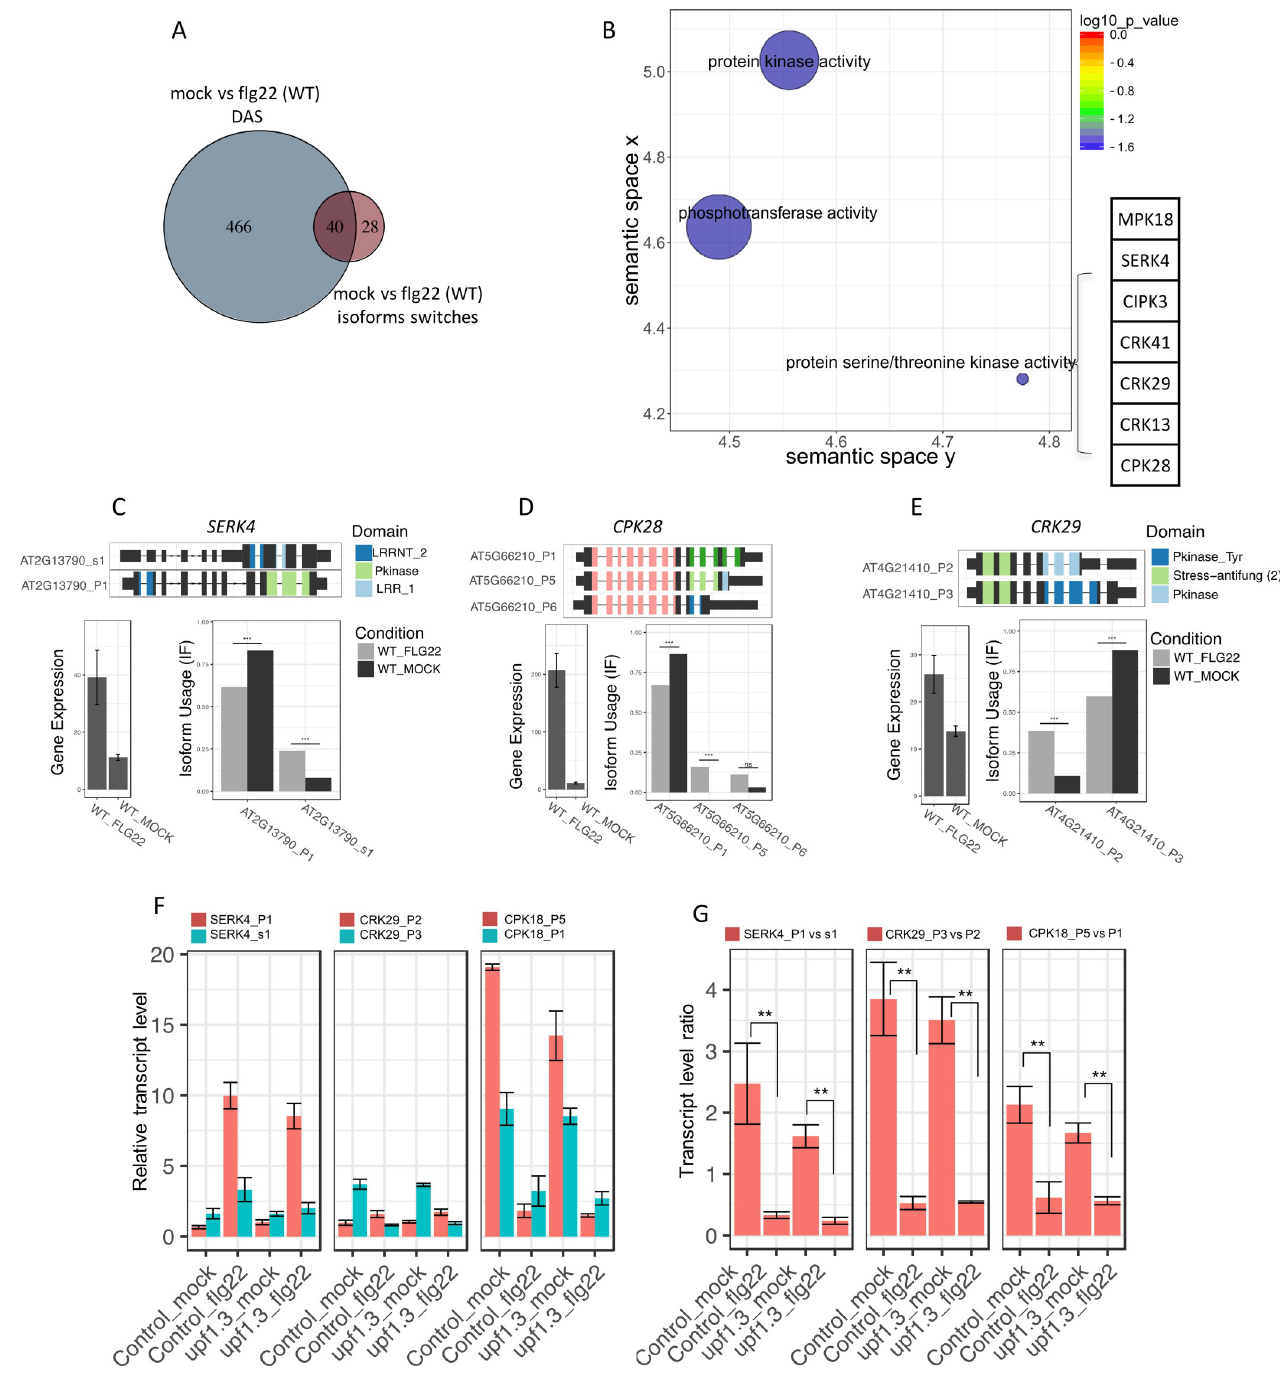
Fig 6. Flg22-induces protein kinase isoform switching. A , Venn comparison plot between DAS genes compared to genes with isoform switching events in response to flg22 in WT. B, REVIGO plots of gene ontology enrichment clusters of DAS genes both in mpk4 compared to wild type and in response to flg22 in wild-type plants. Each circle represents a significant GO category but only groups of highest significance are labeled. Related GOs have similar (x, y) coordinates. C-D-E , Results of IsoformSwitchAnalysisR showing the gene diagram of differential isoforms with the predicted PFAM domain, change in gene expression and relative isoform abundance in response to flg22 and isoform-specific RT-qPCR analysis showing F , the relative transcript abundance (normalized against the housekeeping gene AT4G26410) and G ratio of isoform abundances in response to mock or flg22 treatment in WT and upf1upf3 for SERK4, CPK28 and CRK29. Significant differences were estimated by student t-test ( �� p-value < 0.01).